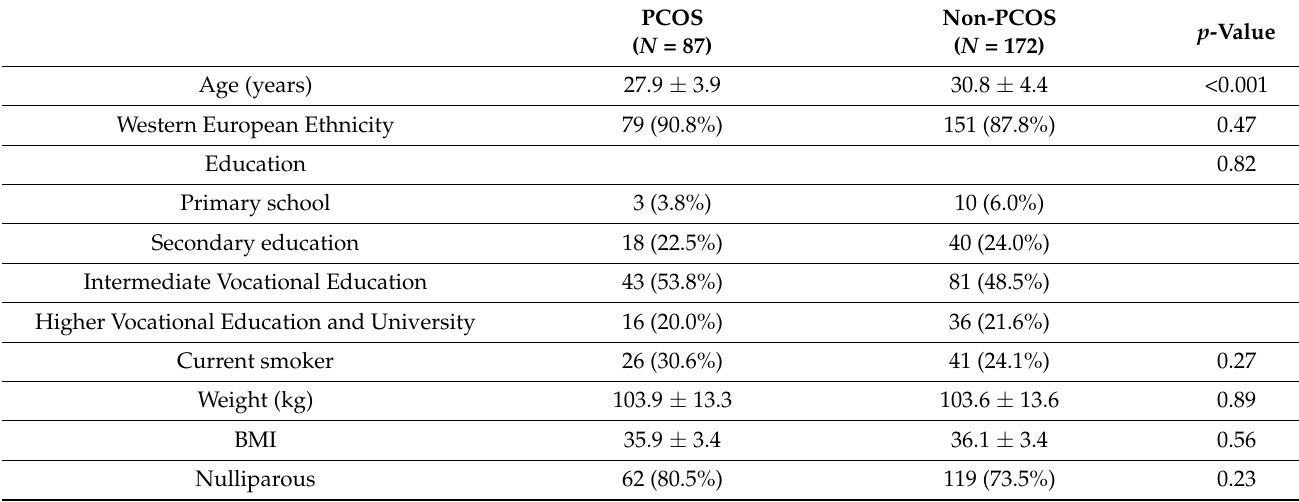
Table 1. Baseline characteristics of participants allocated to the intervention